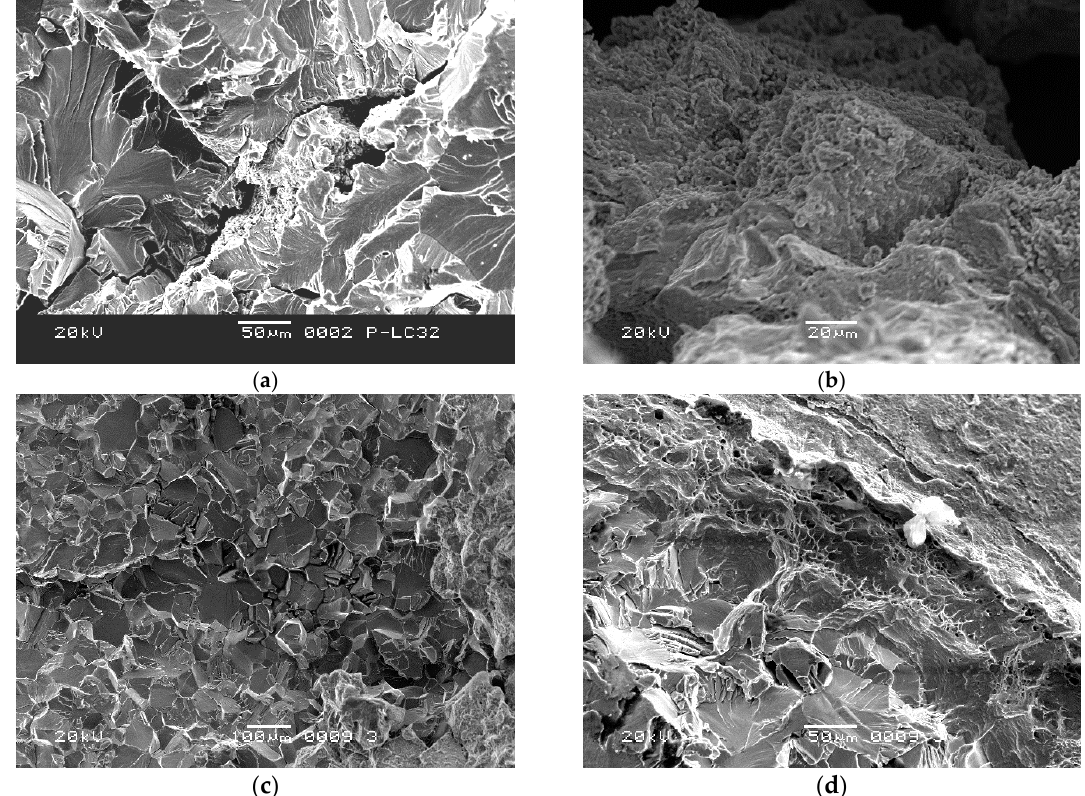
Figure 4. ( a ) Axial cracking and cleavage characteristics in the center of the fracture surface (Region 1 in Figure 3, 50 μ m); ( b ) High magnification of the axial crack (Region 2 in Figure 3, 20 μ m); ( c ) Grain boundary cracking characteristics around the axial crack (Region 3 in Figure 3, 100 μ m), ( d ) Dimple morphology in margin of the fracture surface (Region 4 in Figure 3, 50 μ m).